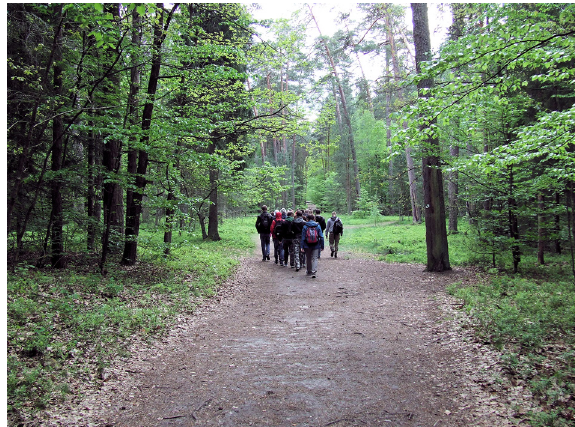
Fig. 2. Zwierzyniec, Poland. The educational path to Bukowa Góra Reserve (Photo: E. Skowronek).